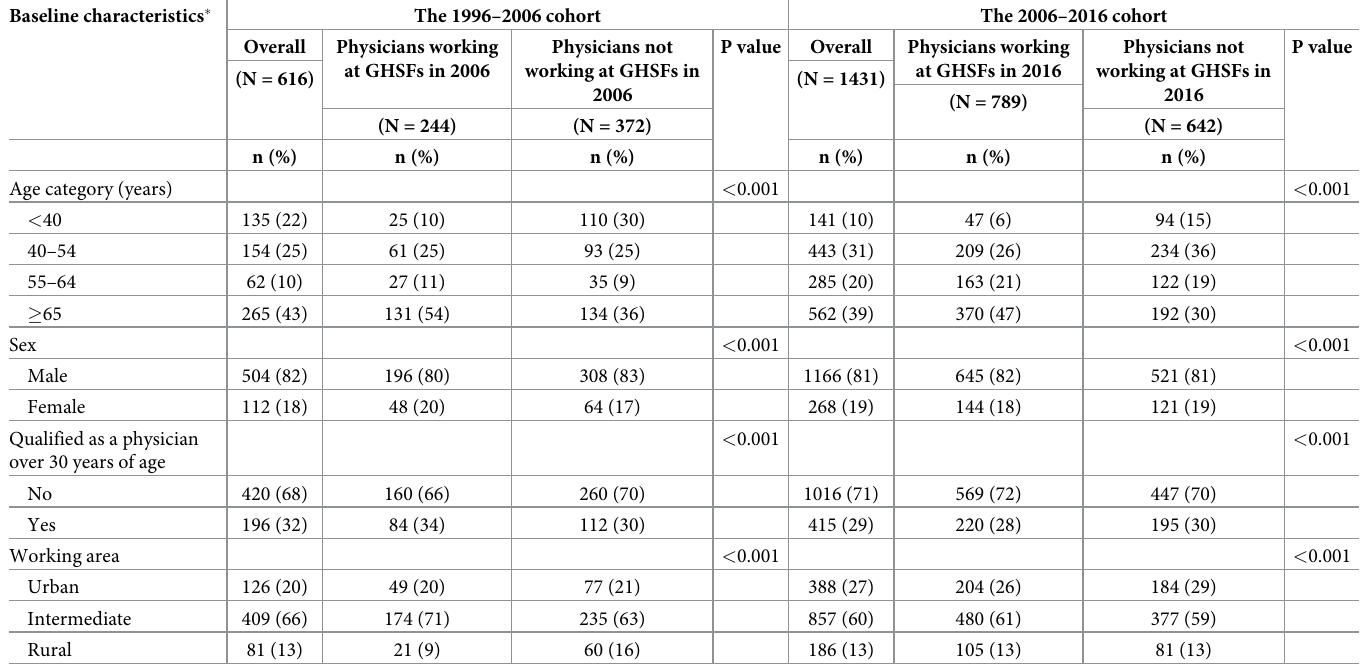
Table 4. Baseline characteristics of physicians already working at GHSFs from 1996–2006 and 2006–2016 cohorts overall and by outcome status. Baseline characteristics